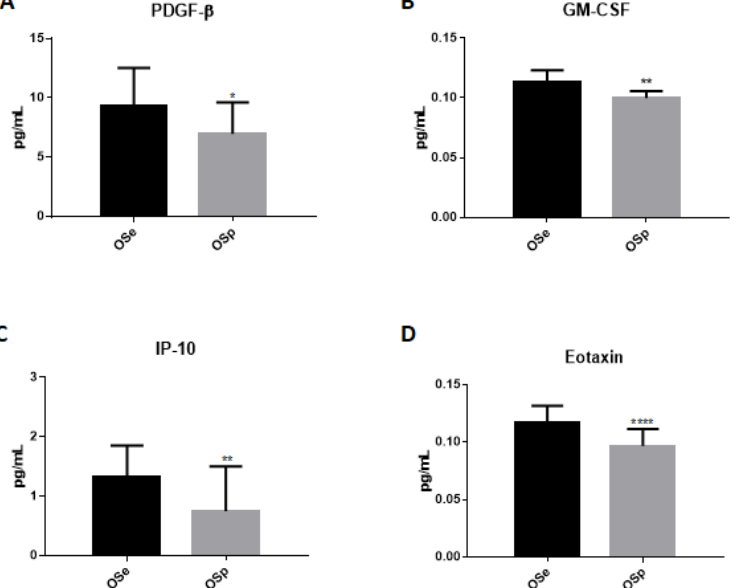
Figure 4. Dosage of cytokines and chemokines in the serum of sedentary obese children (OSe) compared to obese children who played sport (OSp). ( A ) PDGF- β , ( B ) GM-CSF, ( C ) IP-10, ( D ) Eotaxin. The data are expressed as the means ± SDs. The significance was determined by the Student’s t -test: * ( p < 0.05), ** ( p < 0.01) and **** ( p < 0.0001) represent significance compared to sedentary obese children.